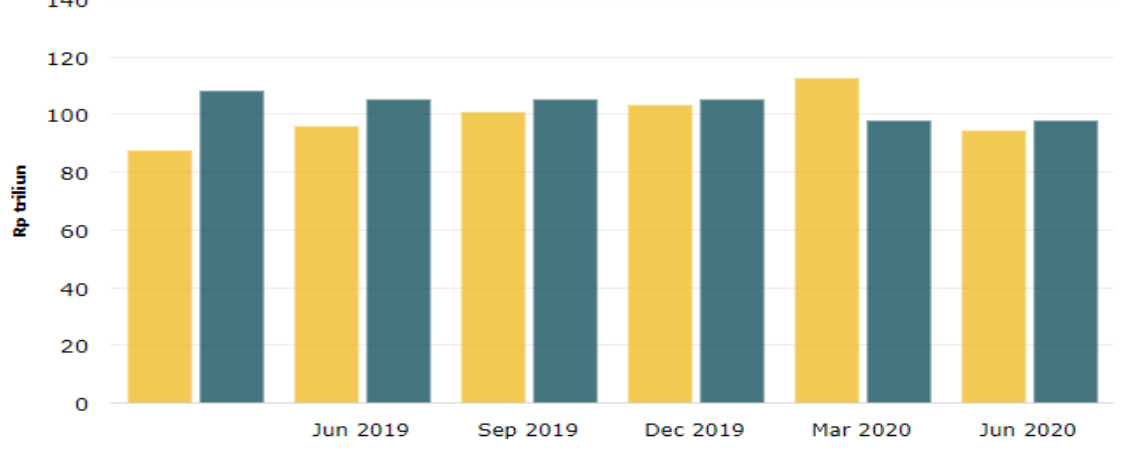
Figure 6: Realization of Indonesia FDI and Domestic